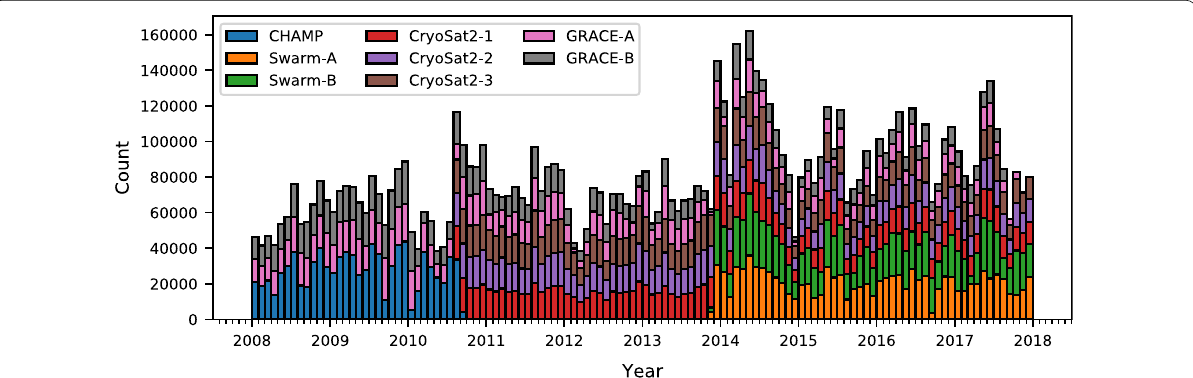
Fig. 2 Number of selected satellite data per month as stacked histogram. Ground observatories contribute with approximately 130 vector measurements of the SV per